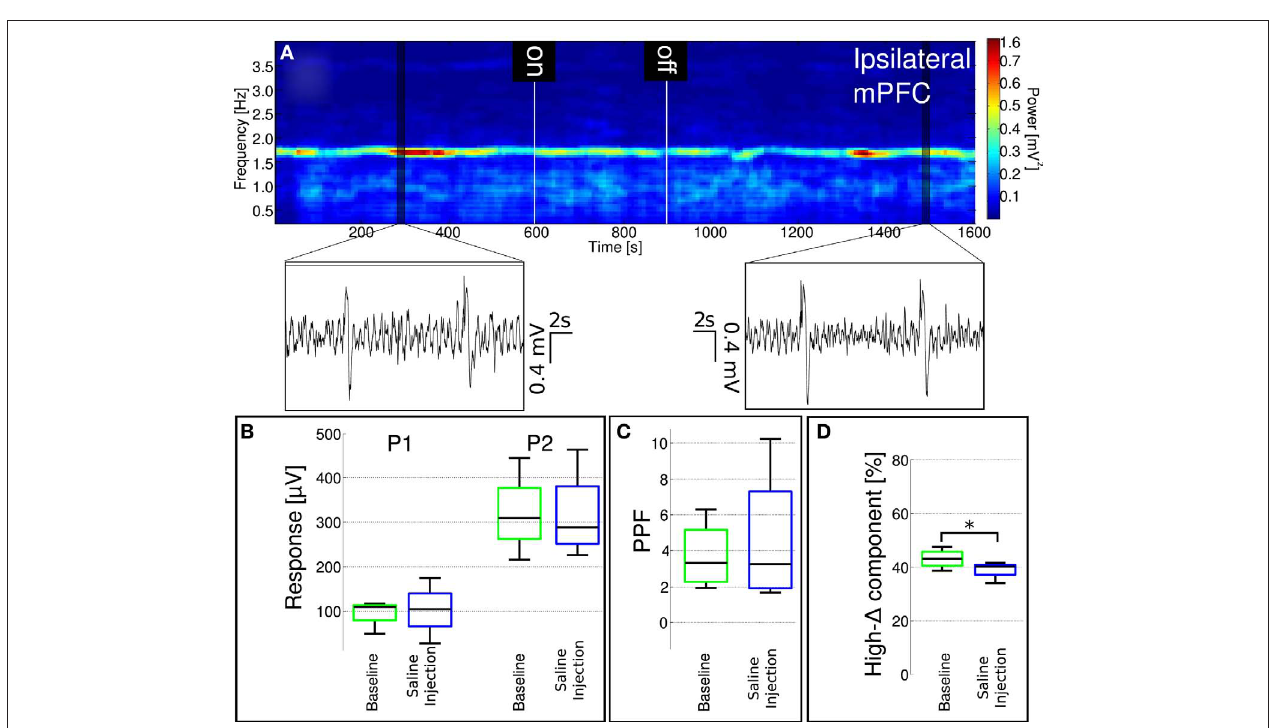
Figure 9 | Localized saline administration into the mediodorsal nucleus of the thalamus does not enhance low-delta activity and fails to replicate effects of localized MK-801 administration. (A) A representative spectrogram of ipsilateral mPFC LFP. Insets show characteristic LFP traces from highlighted regions.